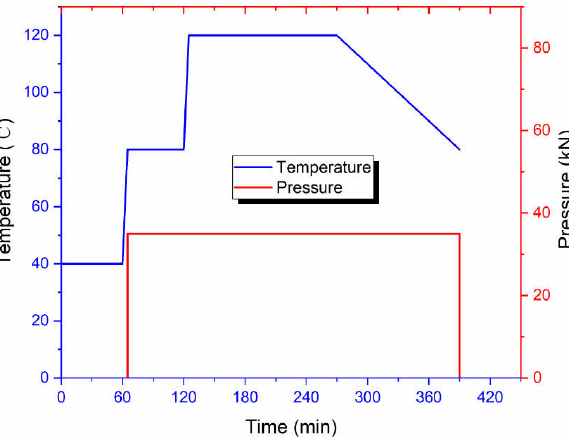
Figure 4: Pressure-molding thermal-curing forming process for CARALL